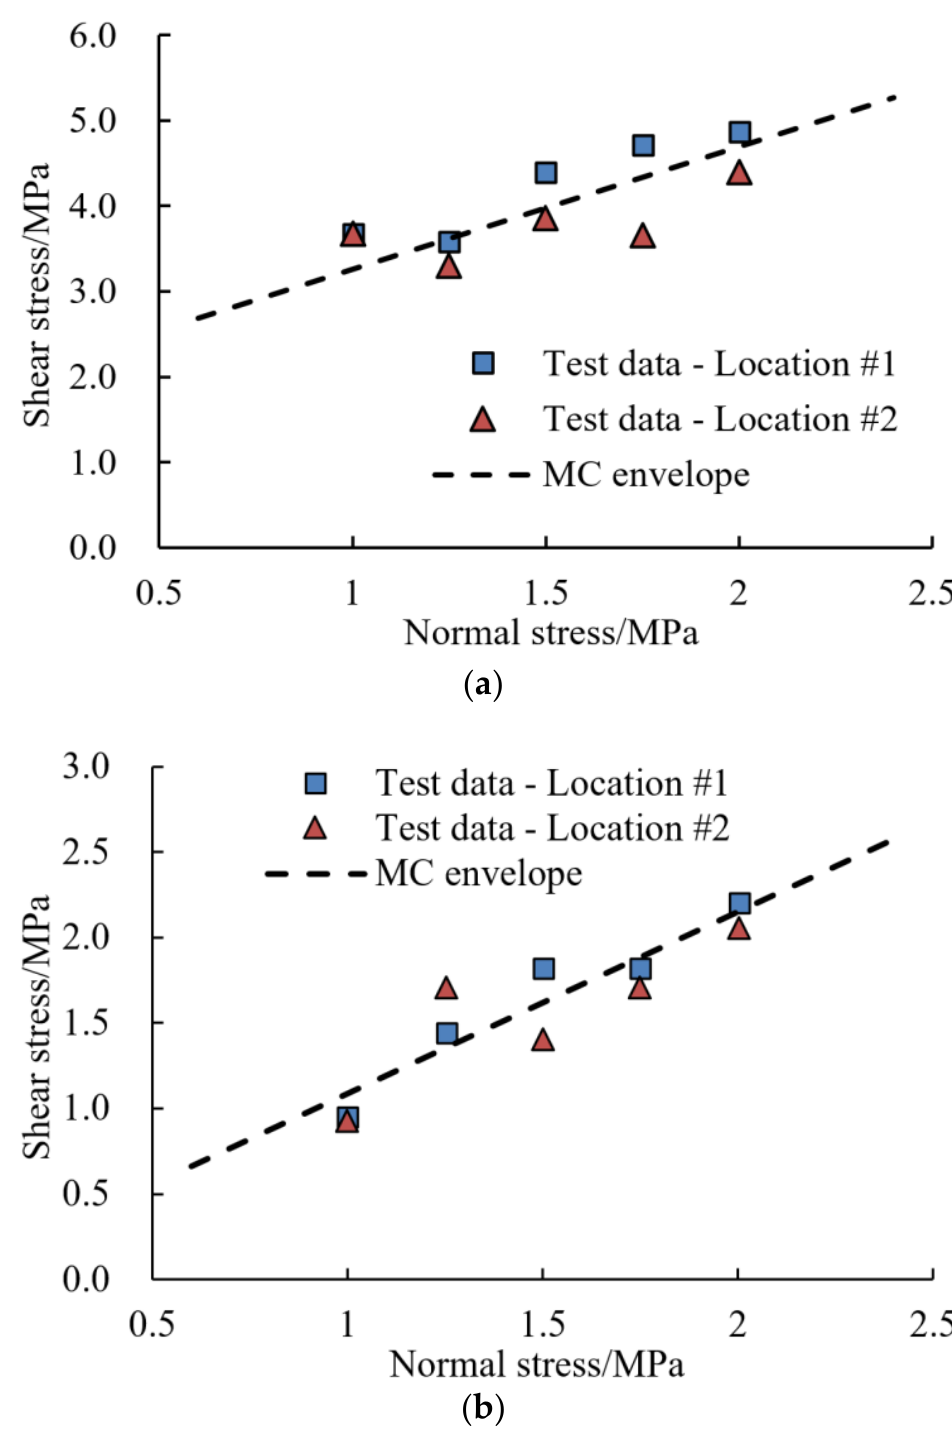
Figure 4. Fitting the test results with the MC criterion. ( a ) Peak strength, ( b ) Resident strength. Table 2. Shear strengths of concrete-rock interface under various normal stresses. Table 1. Tested data of concrete-rock interface under various normal stresses. Location